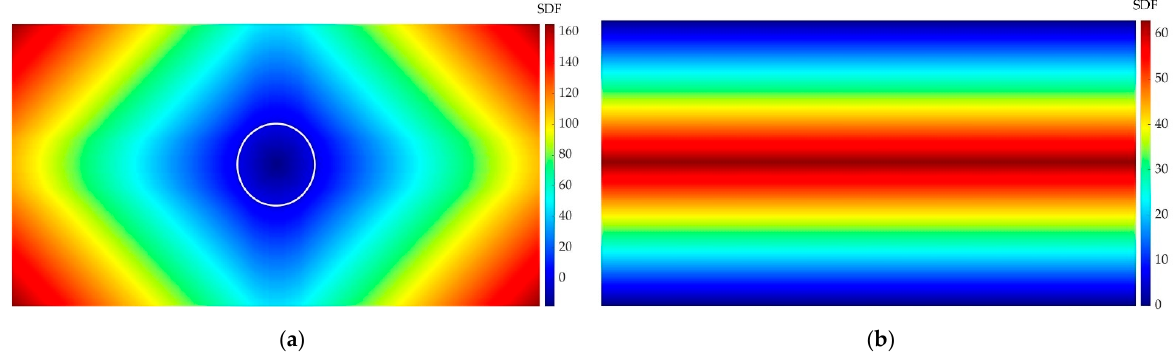
Figure 4. SDF layer examples. ( a ) SDF of the geometry (the outline of the geometry is represented in white); ( b ) SDF of the channel walls.